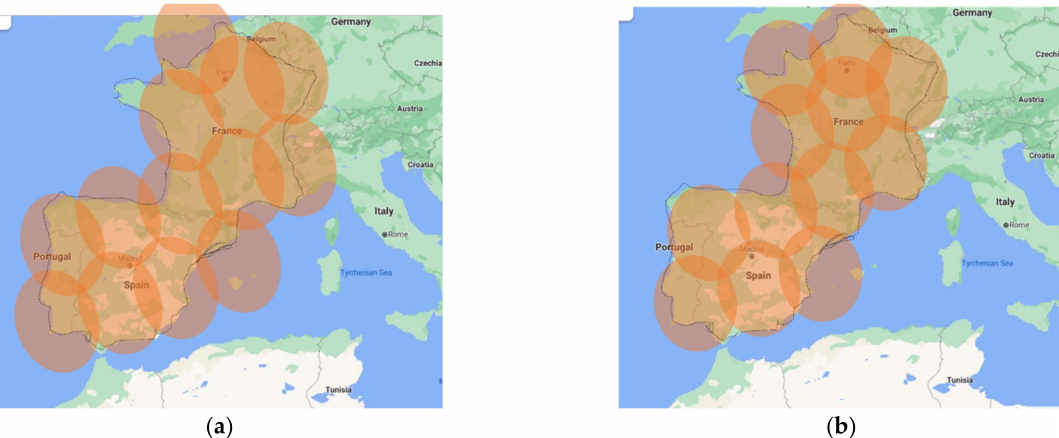
Figure 5. Different number of beams needed for the same service area depending on the configuration of the parameters. ( a ) θ 3dB = 0.66 ◦ and α = 20 ◦ : 13 beams. ( b ) θ 3dB = 0.61 ◦ and α = 18.6 ◦ : 12 beams.